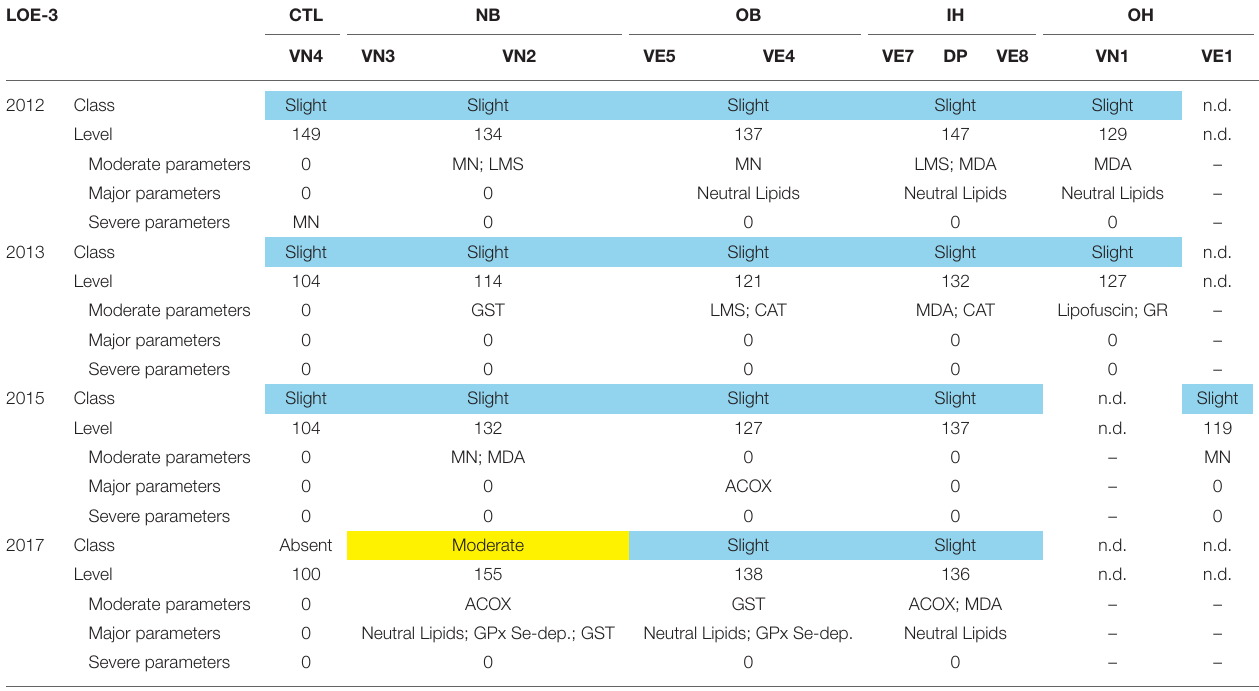
TABLE 3 | Results of the weighted elaboration of biomarkers results, LOE-3.